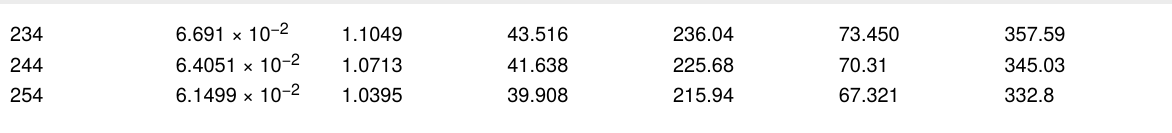
Table 3: Range of base widths ( b ) for V-shaped cantilevers with calculated properties. (continued)